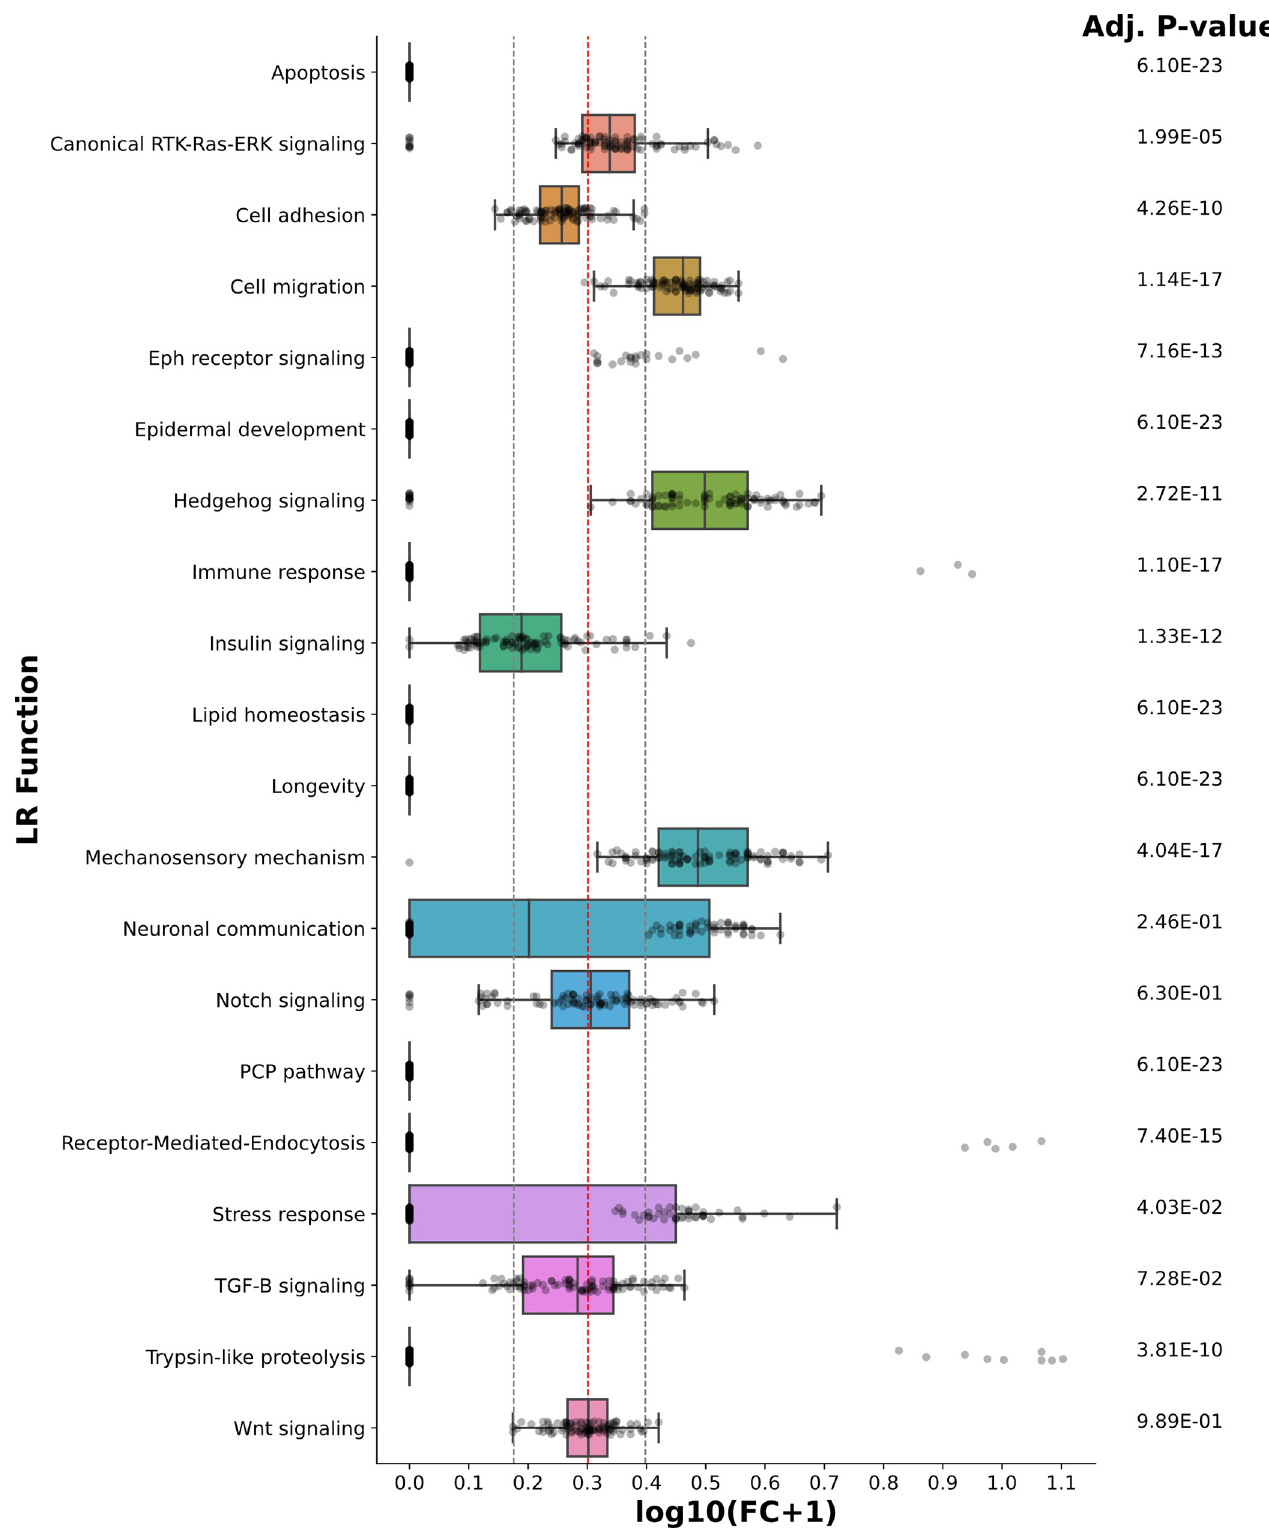
Fig 3. Changes in the relative abundances of signaling functions across initial GA-LR pairs. Boxplots summarizing the changes of the relative abundances for each of the signaling functions that LR pairs are associated with (y-axis). Changes were computed from the fold change (FC) between the relative abundance